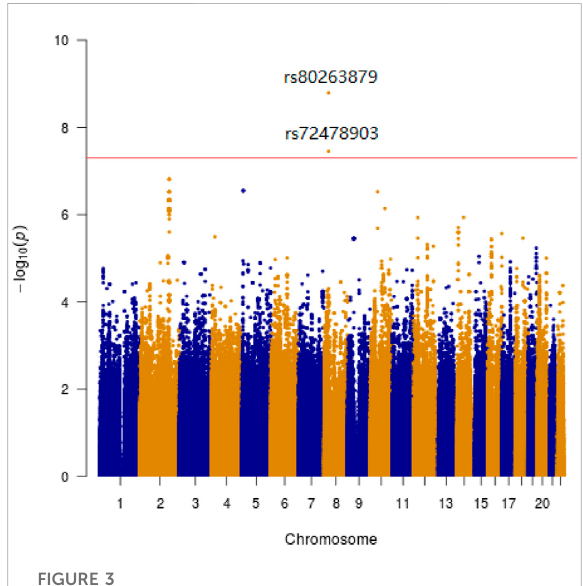
FIGURE 3 Manhattan plot showing genome-wide association analysis for SSWM. X-axis represents the position of SNPs on the chromosome, y-axis represents the signi fi cance level of